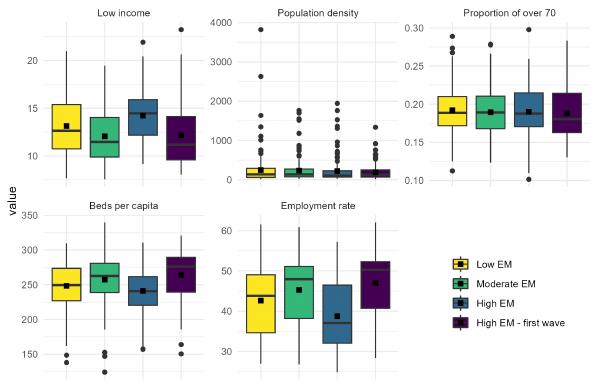
Figure A2. Distribution of socioeconomic variables within clusters.